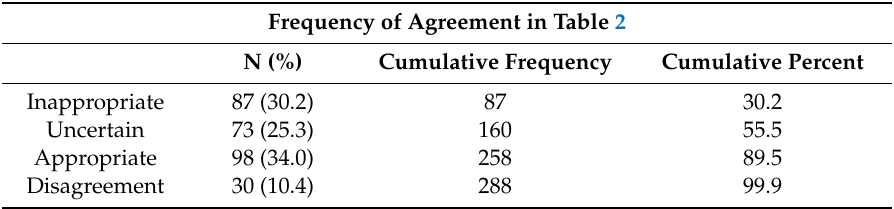
Table 3. Number of scenarios scored as ‘inappropriate’, ‘uncertain’, ‘appropriate’, or ‘disagreement’. *